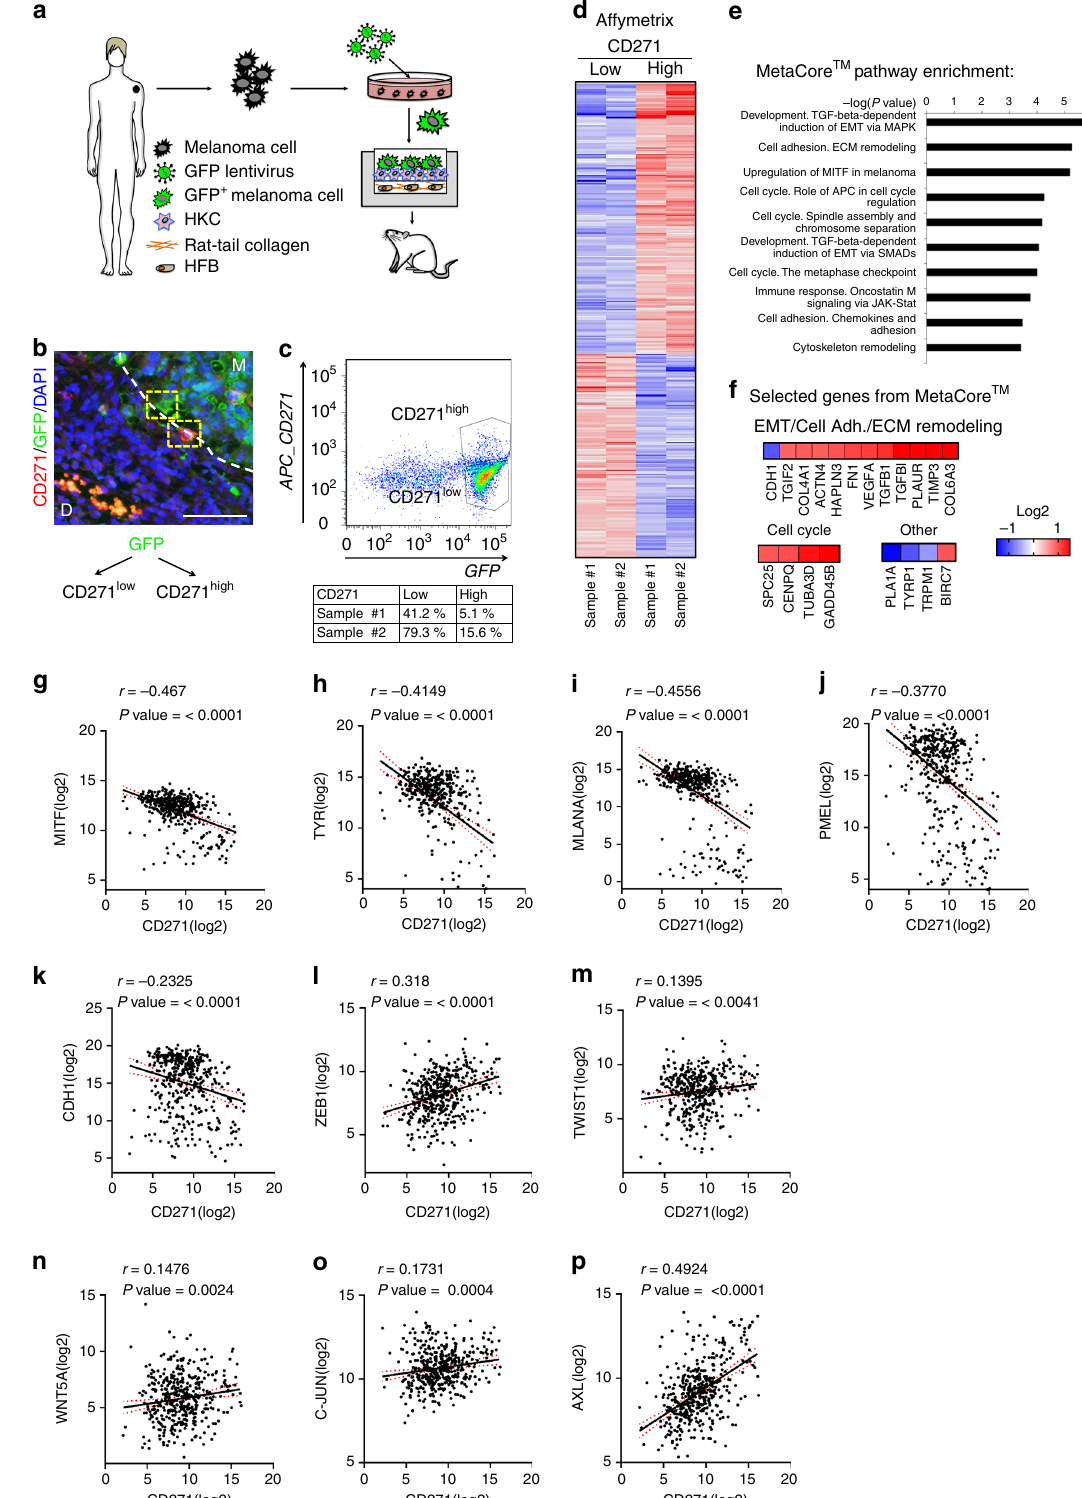
Cell cycle. Spindle assembly and chromosome separation Development. TGF-beta-dependent induction of EMT via SMADs Cell cycle. The metaphase